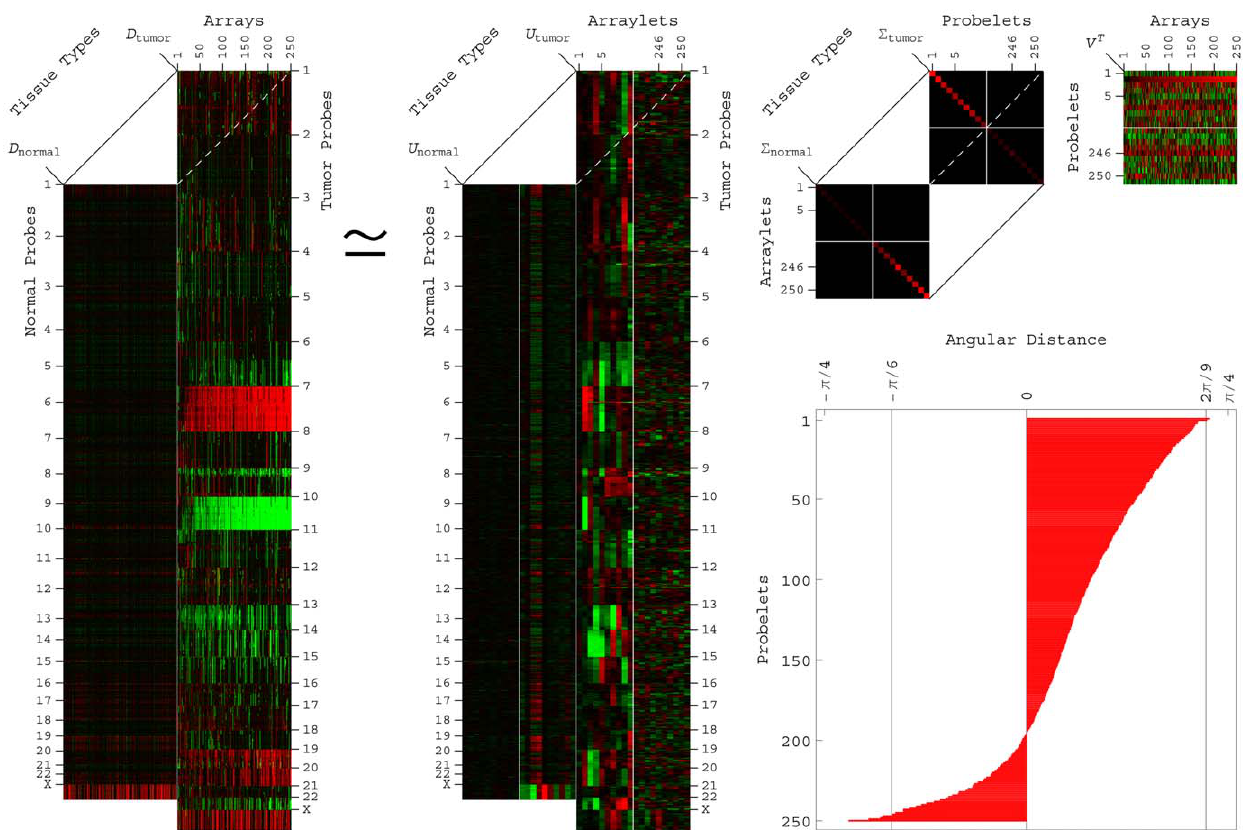
Figure 1. Generalized singular value decomposition (GSVD) of the TCGA patient-matched tumor and normal aCGH profiles. The structure of the patient-matched but probe-independent tumor and normal datasets D 1 and D 2 , of the initial set of N =251 patients, i.e., N -arrays | M 1 =212,696-tumor probes and M 2 =211,227-normal probes, is of an order higher than that of a single matrix. The patients, the tumor and normal probes as well as the tissue types, each represent a degree of freedom. Unfolded into a single matrix, some of the degrees of freedom are lost and much of the information in the datasets might also be lost. The GSVD simultaneously separates the paired datasets into paired weighted sums of N , which is identical for both the outer products of two patterns each: One pattern of copy-number variation across the patients, i.e., a ‘‘probelet’’ v T n tumor and normal datasets, combined with either the corresponding tumor-specific pattern of copy-number variation across the tumor probes, i.e., the ‘‘tumor arraylet’’ u 1, n , or the corresponding normal-specific pattern across the normal probes, i.e., the ‘‘normal arraylet’’ u 2, n (Equation 1). This is depicted in a raster display, with relative copy-number gain (red), no change (black) and loss (green), explicitly showing only the first though the 10th and the 242nd through the 251st probelets and corresponding tumor and normal arraylets, which capture * 52% and 71% of the information in the in the tumor dataset relative to its significance in the normal dataset is tumor and normal dataset, respectively. The significance of the probelet v T n defined in terms of an ‘‘angular distance’’ that is proportional to the ratio of these weights (Equation 4). This is depicted in a bar chart display, showing that the first and second probelets are almost exclusive to the tumor dataset with angular distances w 2 p /9, the 247th to 251st probelets are approximately exclusive to the normal dataset with angular distances * v { p = 6 , and the 246th probelet is relatively common to the normal and tumor datasets with an angular distance w { p = 6 . We find and confirm that the second most tumor-exclusive probelet, which is also the most significant probelet in the tumor dataset, significantly correlates with GBM prognosis. The corresponding tumor arraylet describes a global pattern of tumor- exclusive co-occurring CNAs, including most known GBM-associated changes in chromosome numbers and focal CNAs, as well as several previously unreported CNAs, including the biochemically putative drug target-encoding TLK2 [22–25]. We find and validate that a negligible weight of the global pattern in a patient’s GBM aCGH profile is indicative of a significantly longer GBM survival time. It was shown that the GSVD provides a mathematical framework for comparative modeling of DNA microarray data from two organisms [12,39]. Recent experimental results [40] verify a computationally predicted genome-wide mode of regulation [41,42], and demonstrate that GSVD modeling of DNA microarray data can be used to correctly predict previously unknown cellular mechanisms. This GSVD comparative modeling of aCGH data from patient-matched tumor and normal samples, therefore, draws a mathematical analogy between the prediction of cellular modes of regulation and the prognosis of cancers.